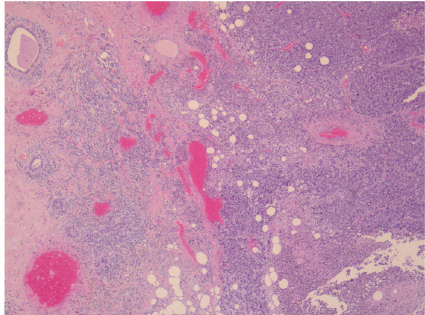
Figure 3: Histological appearanceof infiltrative lesion (on the right) of the breast (on the left) composed of sheets of small round blue cells (Hematoxylin & eosin, original magnification X50).